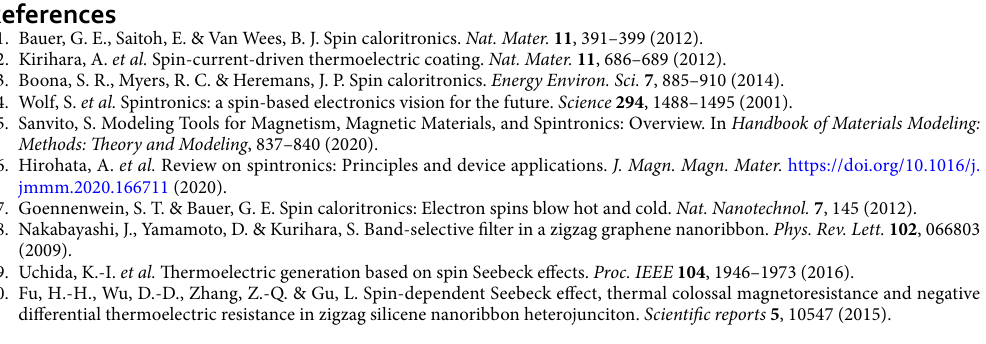
GSNRs by selecting various device temperature sets. The results reported and discussed in this study are limited to the considered set of parameters and thus they cannot be generalized for various values of external fields.